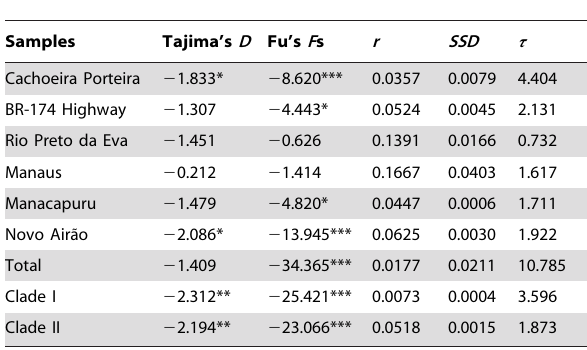
Table 4. Neutrality tests and population expansion parameters estimated for each sample, combined data and haplotype clade of Lutzomyia umbratilis .